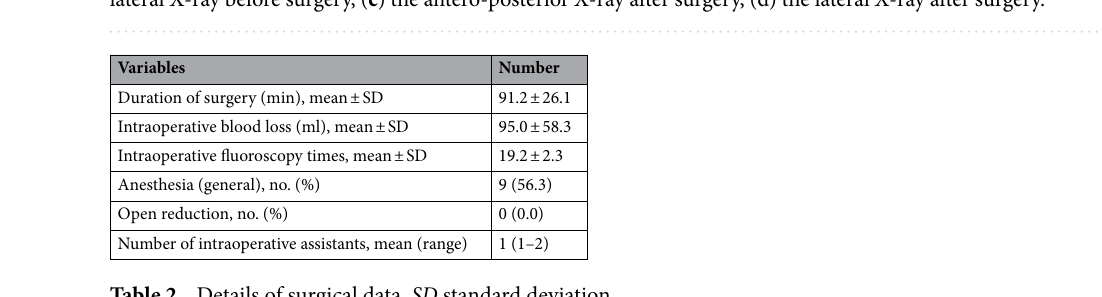
Figure 3. A 38-year-old male with the tibial shaft fracture. ( a ) The antero-posterior X-ray before surgery ( b ) the lateral X-ray before surgery, ( c ) the antero-posterior X-ray after surgery, (d) the lateral X-ray after surgery.